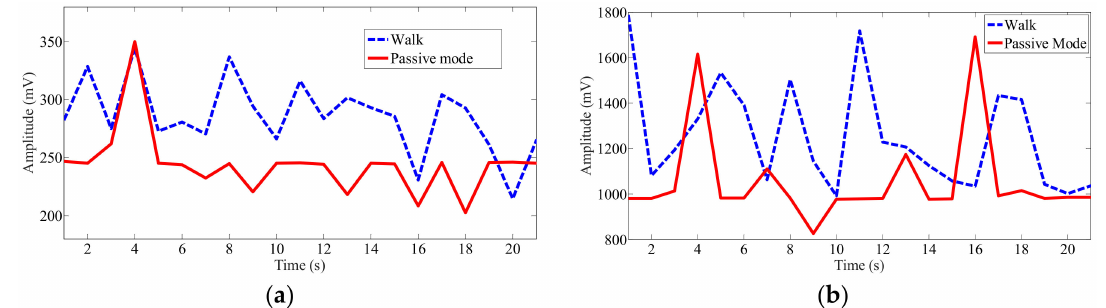
Figure 13. Mean and maximum recorded EMG signal values at left gluteus medius muscle location for each active event during walking and pedaling in passive mode at 16 r/min: ( a ) Mean value at left side; ( b ) Maximum value at left